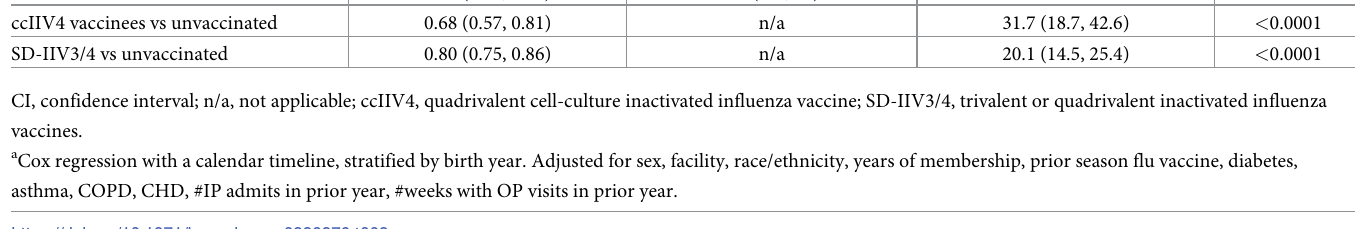
Vaccine Effectiveness (VE) Against Influenza A